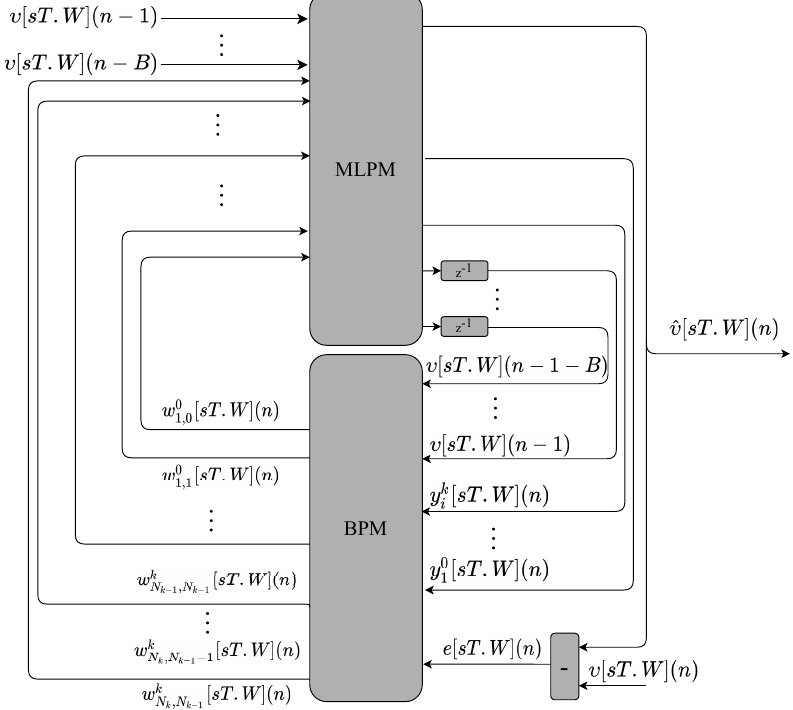
Figure 10. Main hardware modules implemented to perform the MLP-BP.